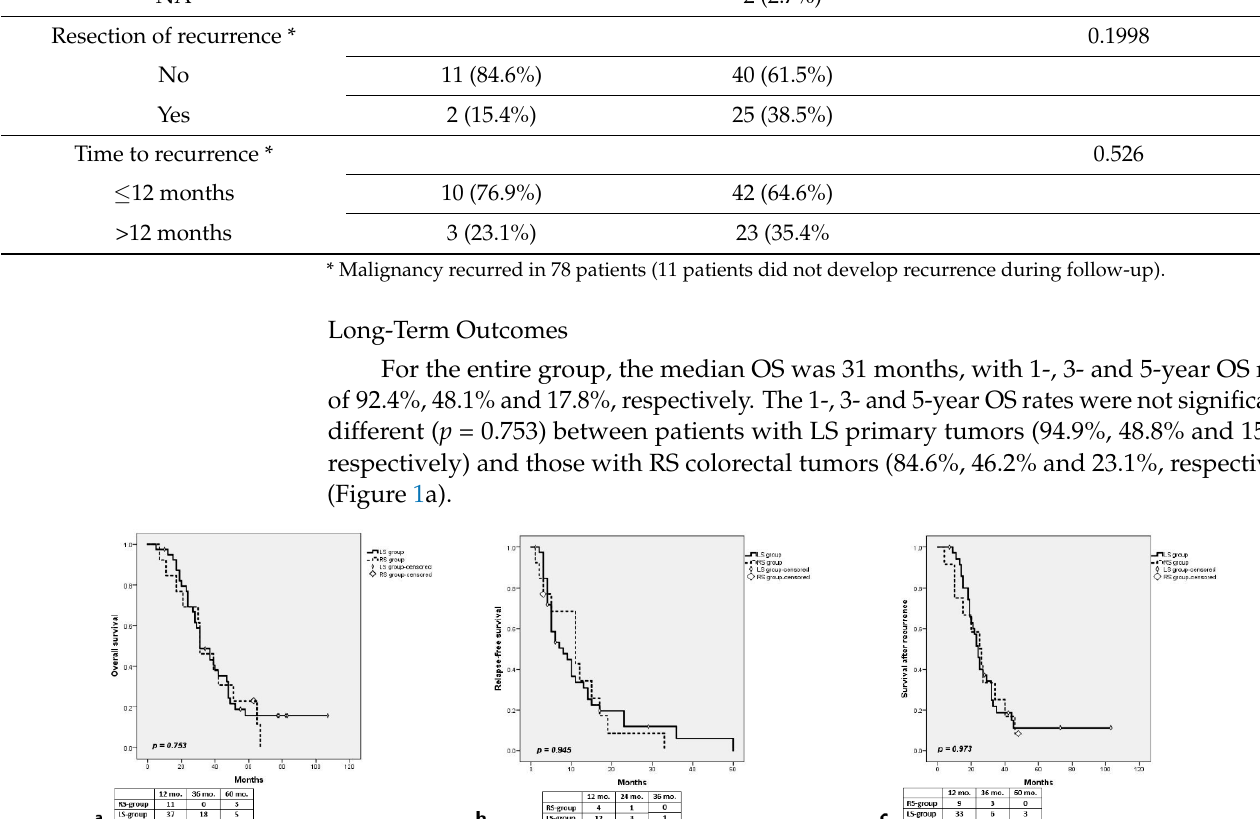
Figure 1. Comparative long-term outcomes between LS group and RS group in patients with RAS- mut CLMs; ( a ) overall survival; ( b ) relapse-free survival; ( c ) survival after recurrence. After a median follow-up of 31 months, 48 patients developed recurrence: hepatic only— 23 patients; hepatic and extrahepatic—10 patients; lung—7 patients; peritoneal—2 patients; lymph nodes—2 patients; local recurrence—2 patients; ovarian—1 patient; and bone— 1 patient. For the entire group, the median RFS was 10 months, with 1- and 3-years RFS rates of 33.6%, and 3.6%, respectively. The RFS rates were not statistically